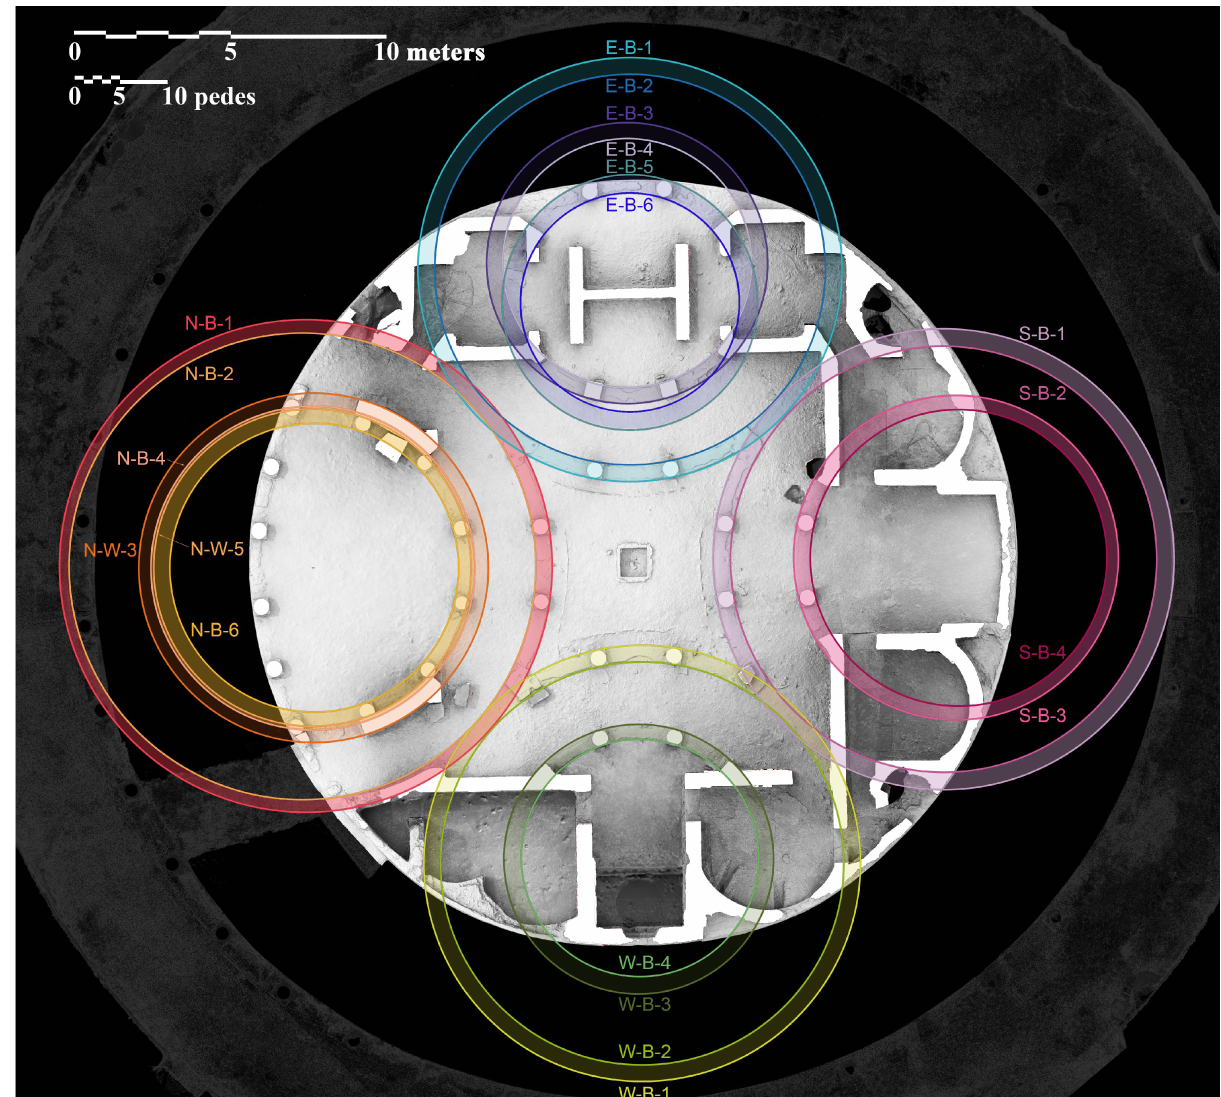
Figure 5. Plan with the indication of the codes and the positions of the